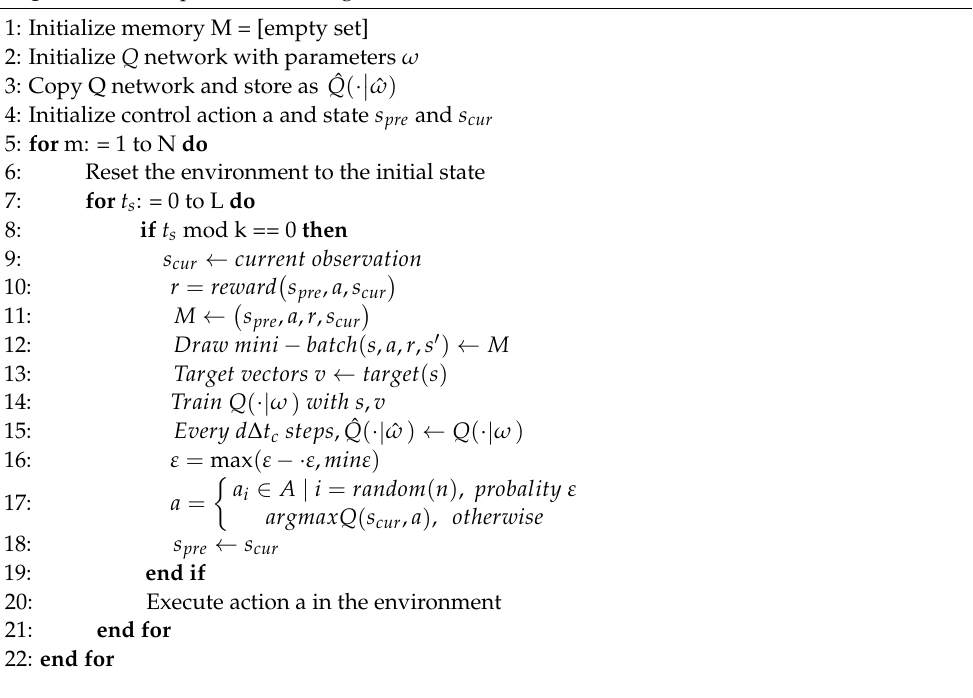
Algorithm 1 : Deep Q Network Algorithm